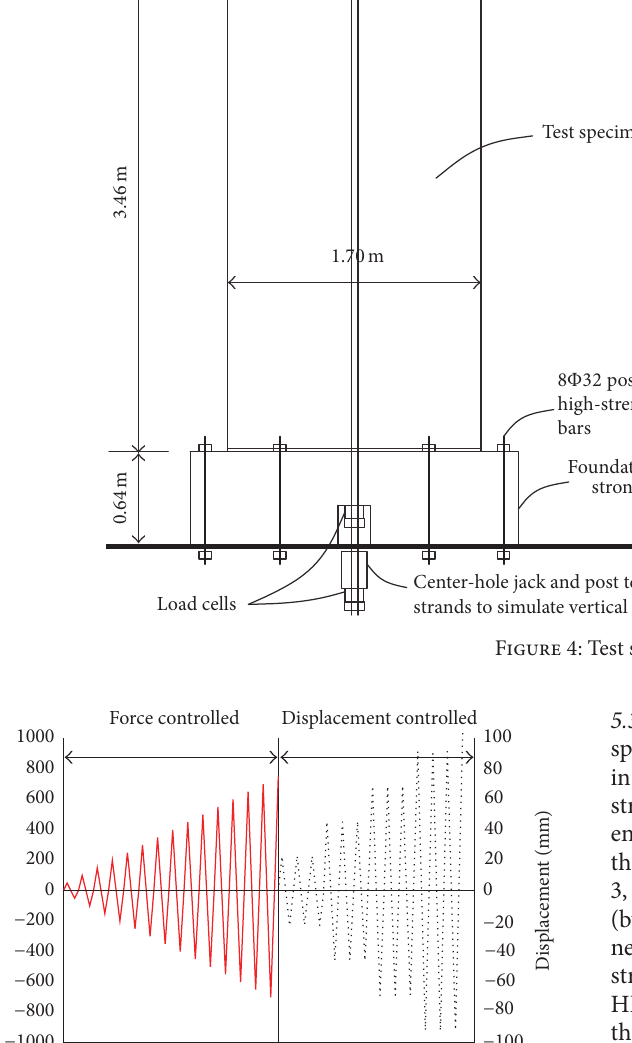
Figure 5: Load history. (1kN = 0.22 kips, 1 mm = 0.04in.)